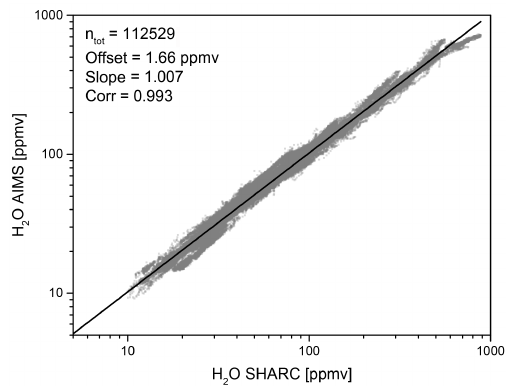
Figure 11. H 2 O mixing ratio of AIMS-H 2 O plotted versus the mixing ratio measured by SHARC with data from the entire ML- CIRRUS campaign (gray dots). Offset, slope and correlation coef- ficient of the linear fit function (black line) indicate an excellent overall agreement between both